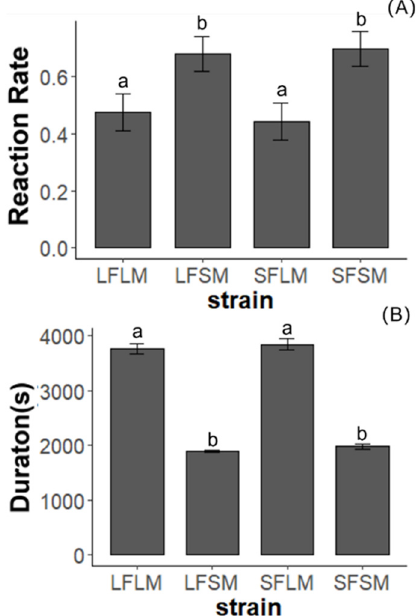
Figure 5. The courtship performance of the SPW for LF×LM, LF×SM, SF×LM, and SF×SM treatments. ( A ) The response of virgin males to females in four treatments. ( B ) The duration of courtship in four treatments. Treatments with different letters are significantly different ( p < 0.05). Error Standard errors are shown on the column bars.